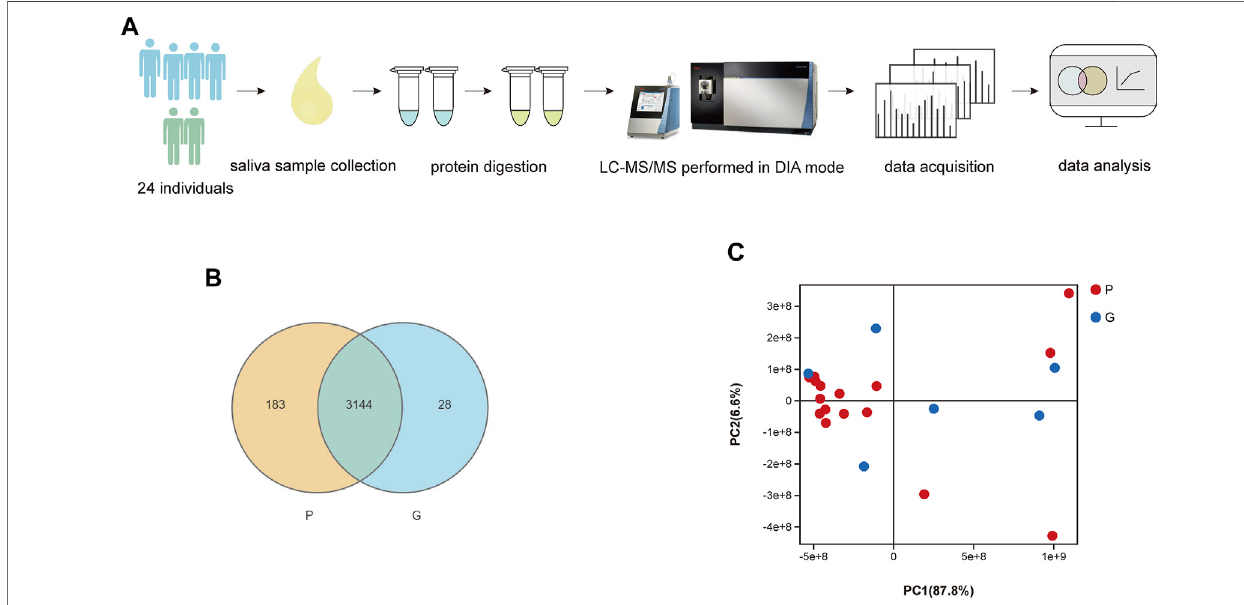
FIGURE 1 | (A) Flow diagram of the study design. (B) Comparison of number of identi fi ed proteins in each sample. Venn-diagram illustrates the sum and percentage of proteins identi fi ed in saliva of each group as well as the overlap between the samples. There were 3,144 different proteins identi fi ed in samples of two groups. (C) PCA analysis of sample relationship. Blue spot indicates the samples of G group, while red spot indicates the P group. PCA plot of samples with G and P groupsshowedaclosedistancewithineachgroupandapartialseparationbetweengroups.Thecompositionofthesampleswithinthegroupwassimilar,whilethe samples were distributed separately between groups, indicating a good agreement and a similarity between those samples in the reduced space.